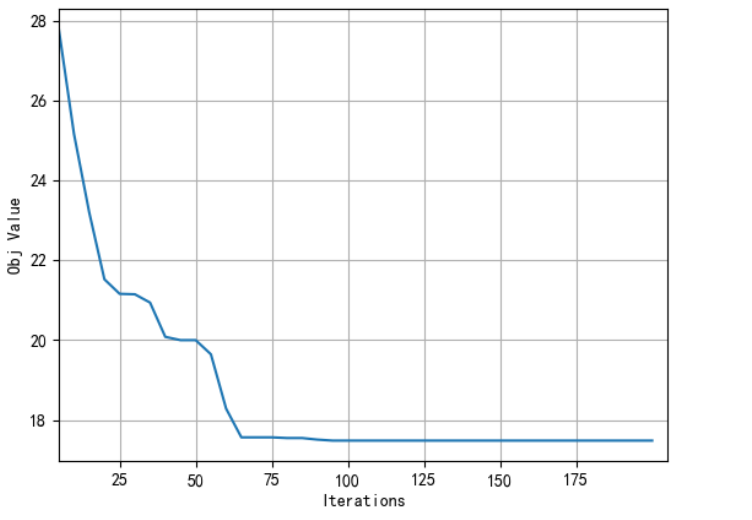
Figure 10. Convergence curve of the objective function value.